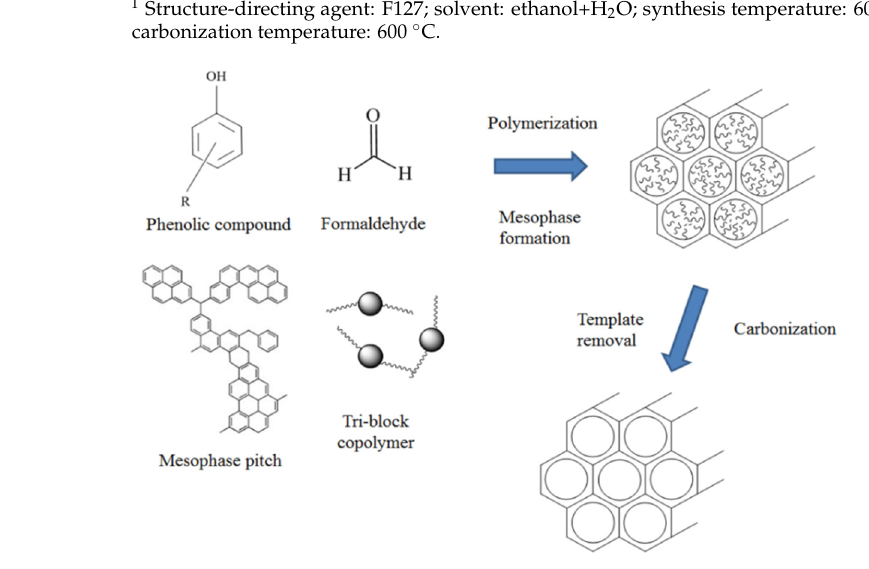
Figure 1. Schematic of the formation mechanism of self-assembled mesoporous